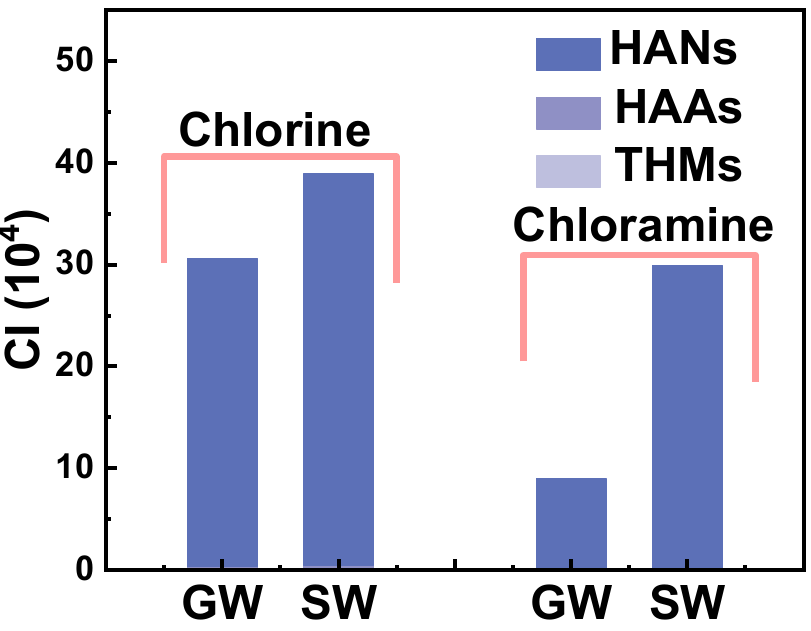
Figure 6. Cytotoxicity indexes of THMs, HAAs, and HANs of GW and SW by chlorine and chloramine disinfection.